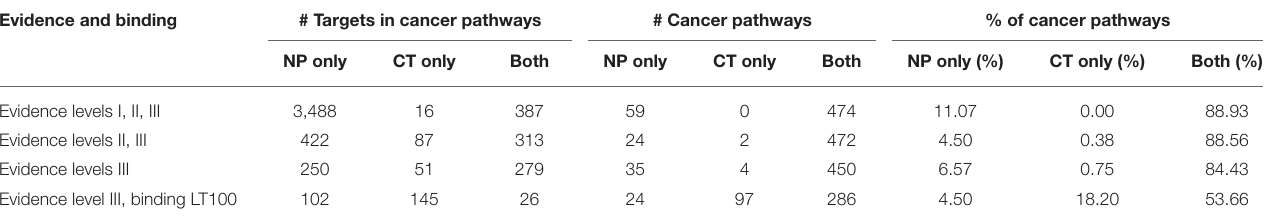
TABLE 5 | Consideration of natural product targets increases both pathway and target coverage in cancer